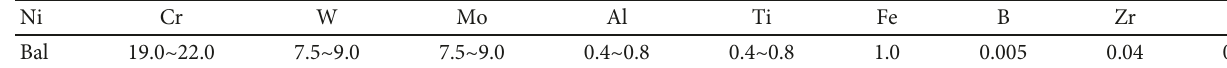
Table 1: Chemical composition of GH3128 (wt.%).